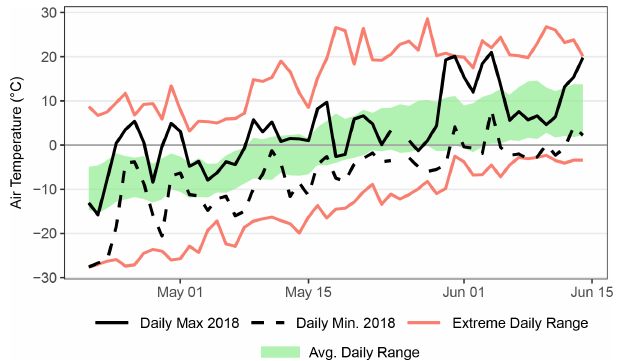
Figure 3. Maximum and minimum daily air temperature in com- parison to the average and extreme values at the Trail Valley Creek field station for the period of